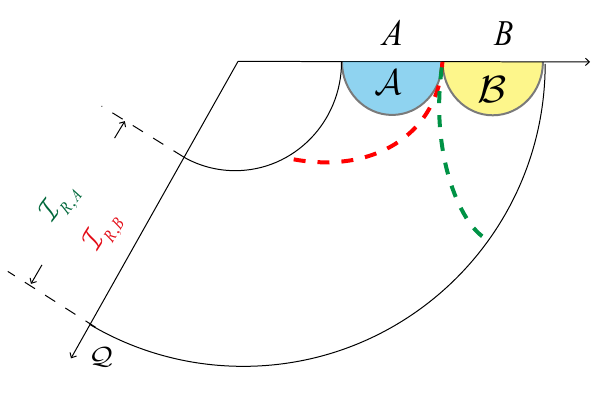
Figure 18 . The phase where AB has an island, but they do not admit an individual. The two possible EWCSs are shown with dashed curves, the corresponding reflected islands are denoted with the same color. These two give the same lower bound for the Markov gap h ≥ c